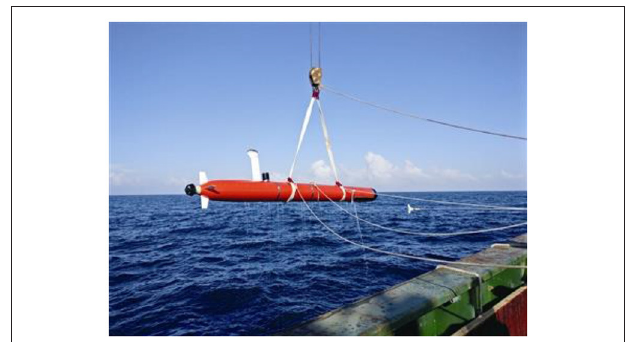
FIGURE 1 | Autonomous underwater